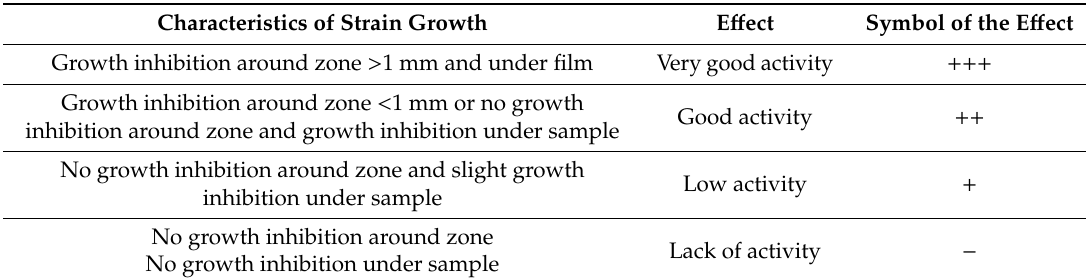
Table 2. Scale for assessing antimicrobial activity of